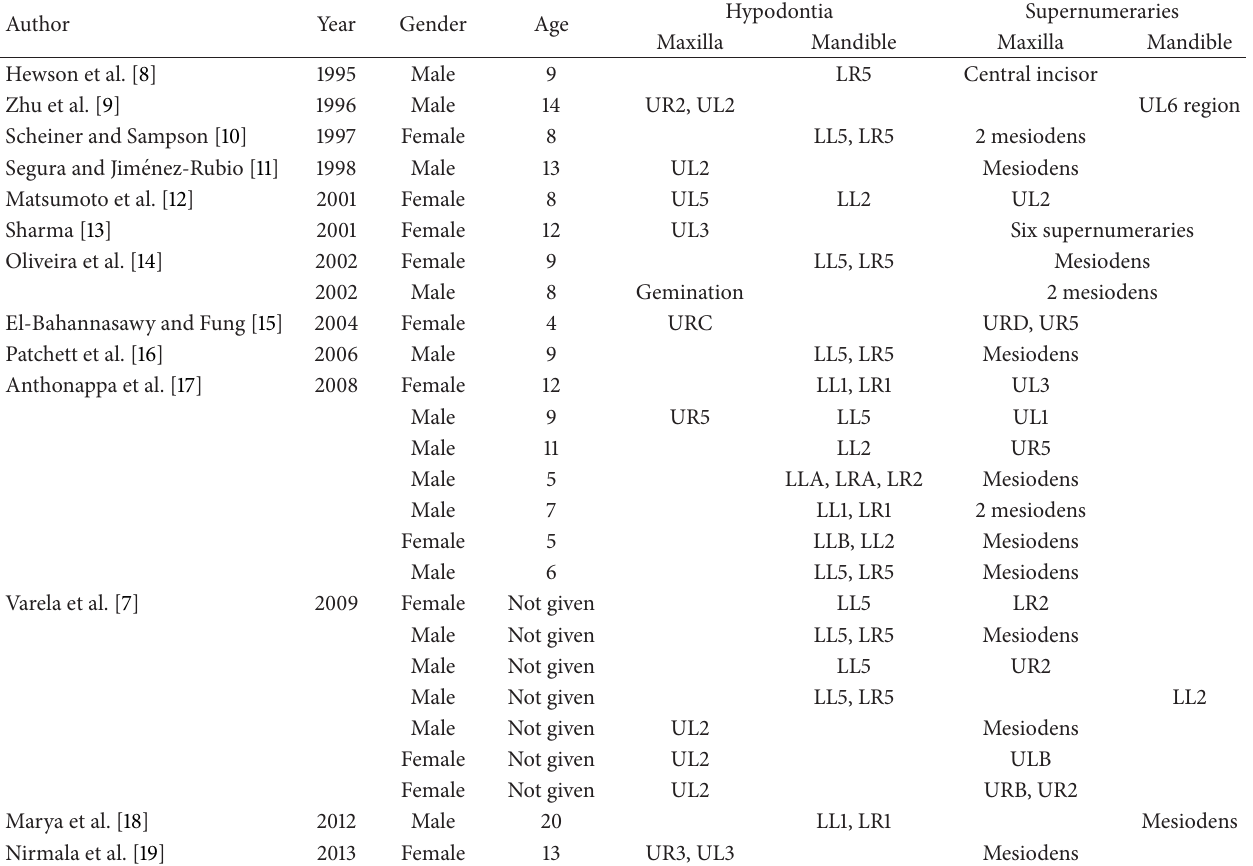
Table 1: Presentation of nonsyndromic CHH in published case reports in English language literature over the last 20 years.